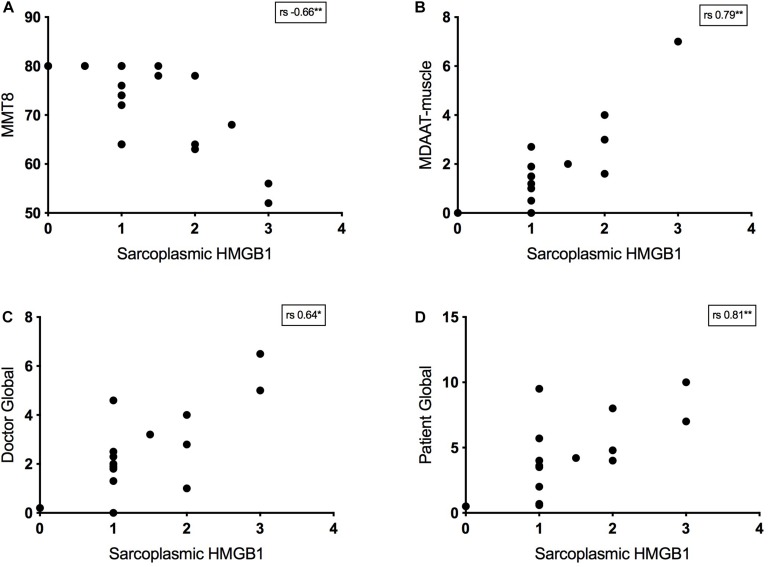
Relationship between bedside disease activity measures and sarcoplasmic HMGB1 grades in IIM patients. Graphs plot HMGB1 grades according to: (A) Manual Muscle Testing 8 scores (MMT8, 0–80). (B) The muscle activity component of the Myositis Disease Activity Assessment Tool by visual analog scale (MDAAT-muscle VAS, 0 – 10). (C) Doctor Global assessment of disease activity by VAS (0 – 10). (D) Patient Global assessment of disease activity by VAS (0 – 10).